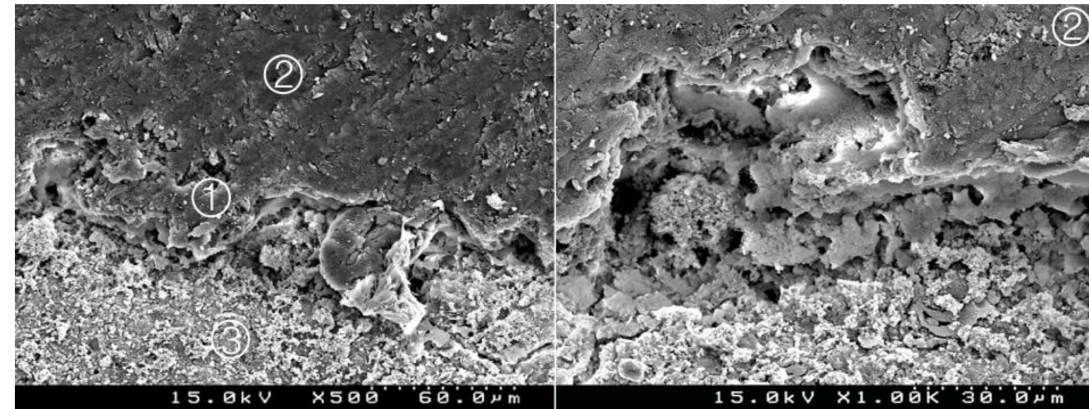
Figure 17. Group 15 (NeoMTAU1I): deep interdigitation between the adhesive and the cement. A thick hybrid layer is presented 1 (cid:13) between the adhesive 2 (cid:13) and the NuSmile ® NeoMTA 3 (cid:13) (original magnification 500 × and 1000 × ).